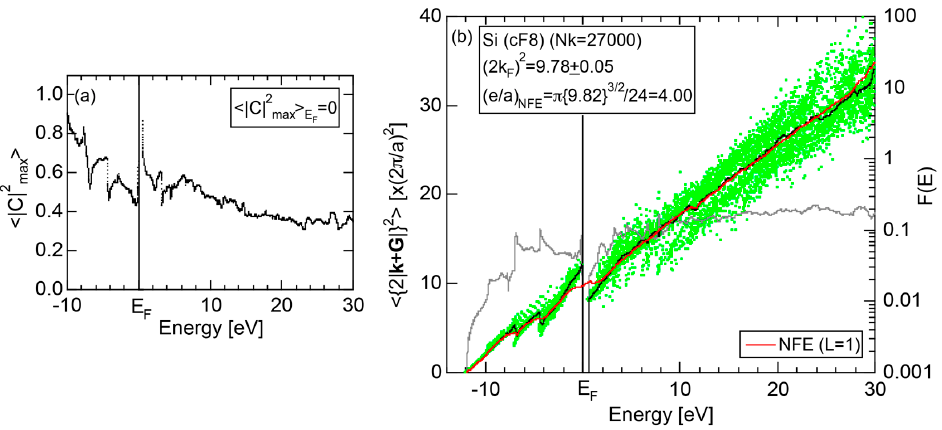
(cid:69) (cid:68) max2 | C | 2 Figure 21. ( a ) and ( b ) Hume-Rothery plot for Si (cF8) [11]. See captions of Figure 19b for max2 Figure 21. ( a ) C and ( b ) Hume-Rothery plot for Si (cF8). See captions of Figure 19 (b) for symbols in ( b ). max C E and ( b ) Hume-Rothery plot for Si (cF8). See captions of Figure 19 (b) for symbols in ( b ). E symbols in (b). Figure 21. ( a ) E